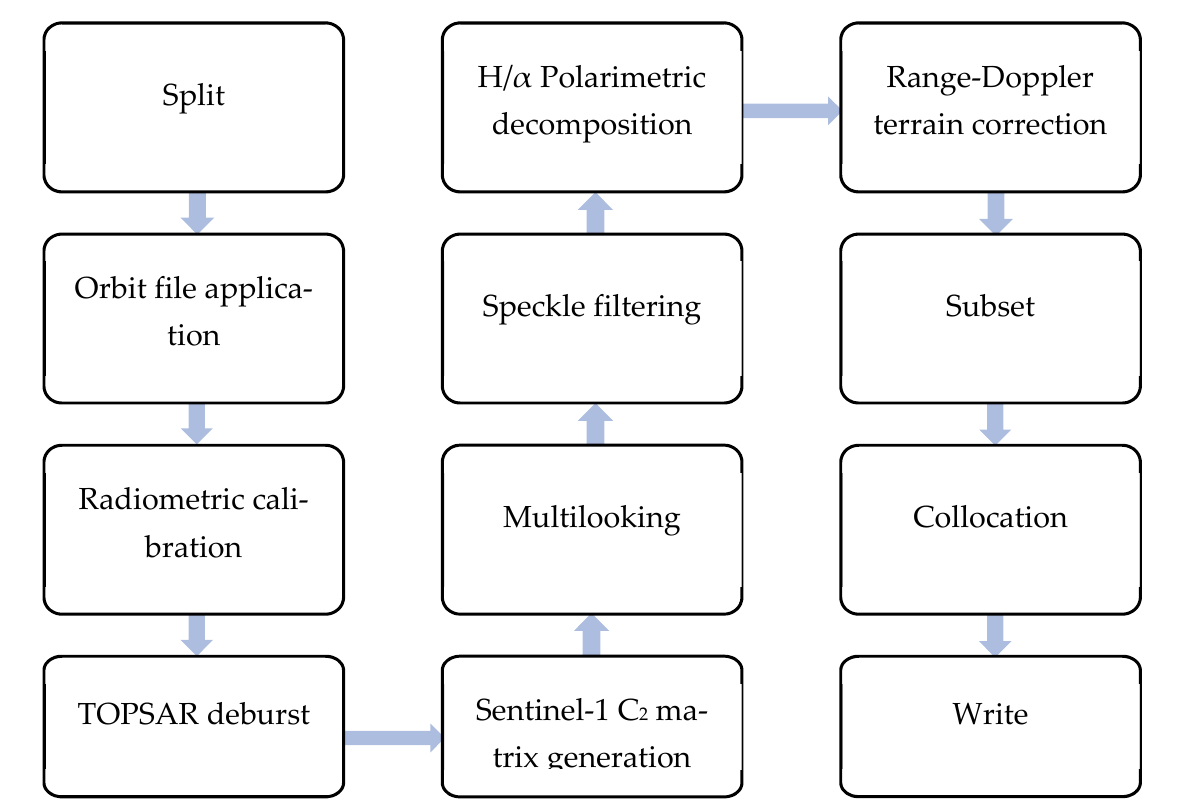
Figure 3. Major preprocessing steps for the Sentinel-1 synthetic aperture radar images. The next preprocessing step was to calibrate the images. SAR calibration produces im- agery with pixel values that correlate with the radar backscatter of the captured scene [48]. Applying the radiometric correction operator also produces images that can be compared with other SAR images acquired with different sensors or acquired from the same sensor but at different times, in different orbits, or processed by different processors. Calibrating the images used in this study is thus relevant, since a multitemporal analysis is to be performed [47]. Creating the multitemporal multiband image requires stacking several Sentinel-1 data collected over the growing season and fusing them with optical data. The calibration process was followed by debursting. Sentinel-1 IW SLC products consist of one image per swath per polarization. The IW products that were used have three swaths. Each sub-swath image consists of a series of bursts. Each burst was processed as a unique SLC image. To merge all these bursts into a single SLC image, the TOPSAR Deburst and Merge operator in the SNAP toolbox was applied. The polarimetric matrix generation process was used to generate a covariance matrix from the Sentinel-1 C-band SAR data [49]. Dual polarimetric SAR sensors collect half of the total polarimetric information involved in fully polarimetric imagery or quad polarization [50]. This implies that the resolution cell at each time point is defined by a 2 × 2 covariance ( C 2 ) matrix that is obtained from C 3 (representing the average polarimetric information extracted from a set of neighboring pixels). The resulting C 2 matrix is represented by Equation (1).